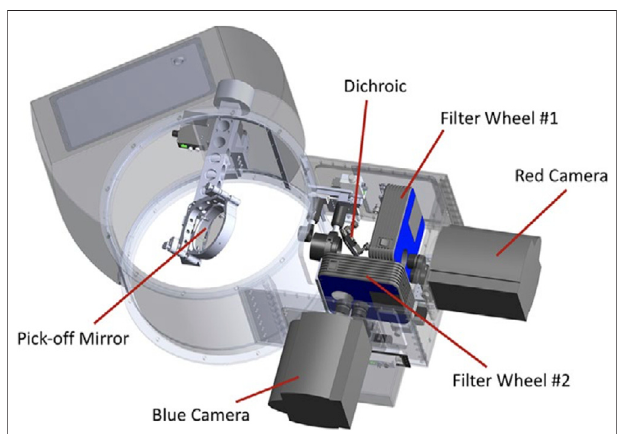
FIGURE 4 | Schematic CAD drawing of ’ Alopeke or Zorro (they are identical),thespeckleinstruments residingat thetwinGemini8-mtelescopes. The compact design is illustrated along with the primary parts labeled. ’ Alopeke and Zorro both mean fox in the language of the local